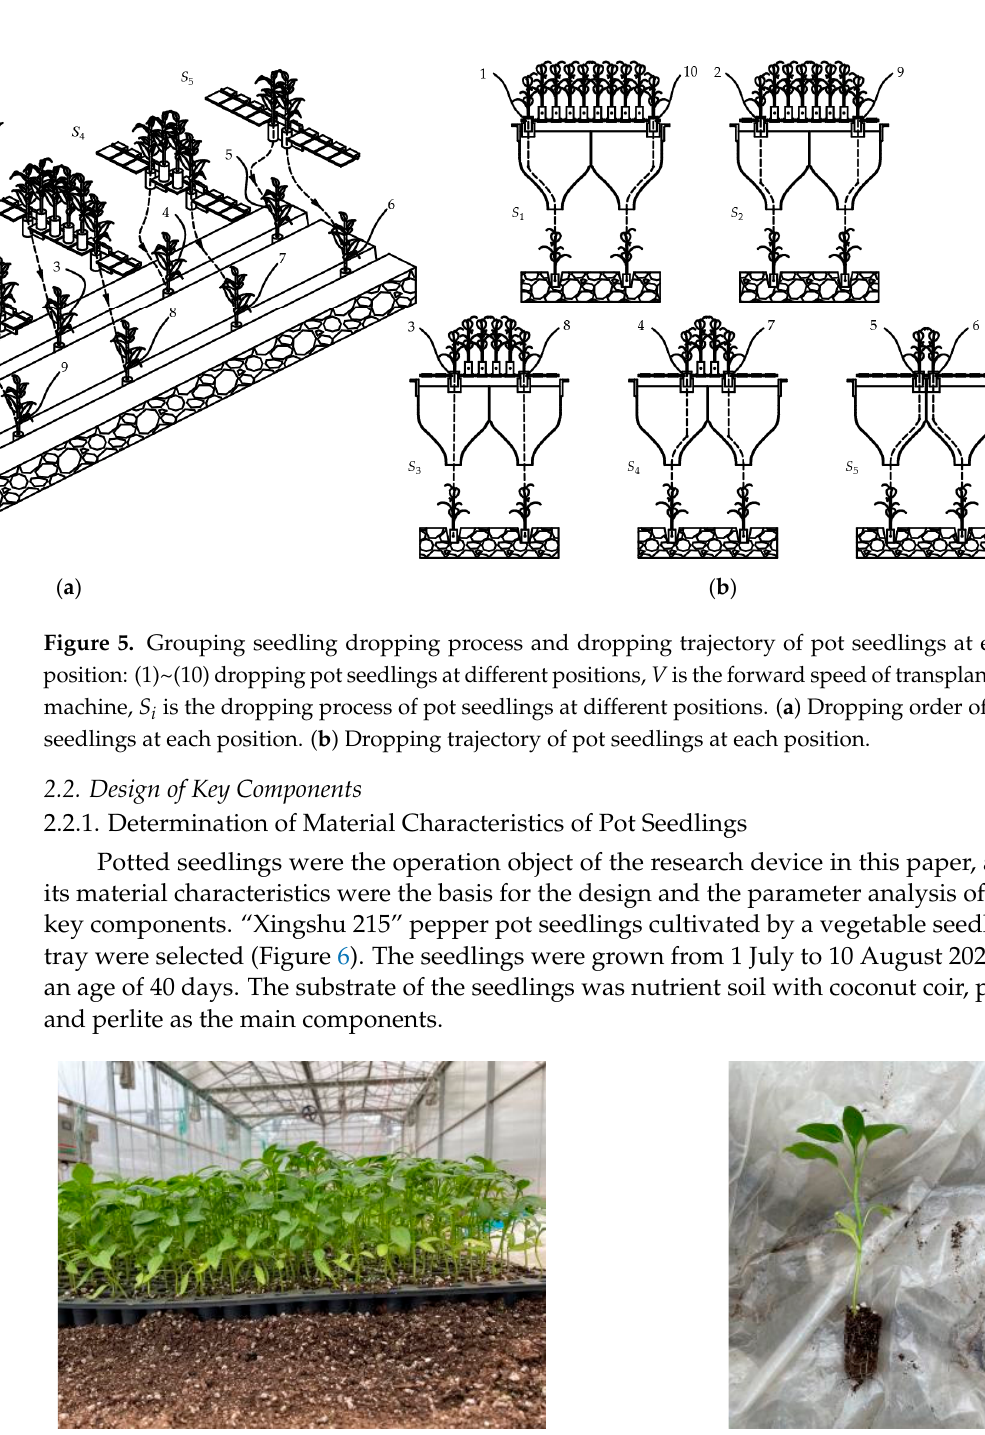
Figure 5. Grouping seedling dropping process and dropping trajectory of pot seedlings at each po ‐ sition: (1)~(10) dropping pot seedlings at different positions, V is the forward speed of transplanting machine, S i is the dropping process of pot seedlings at different positions.